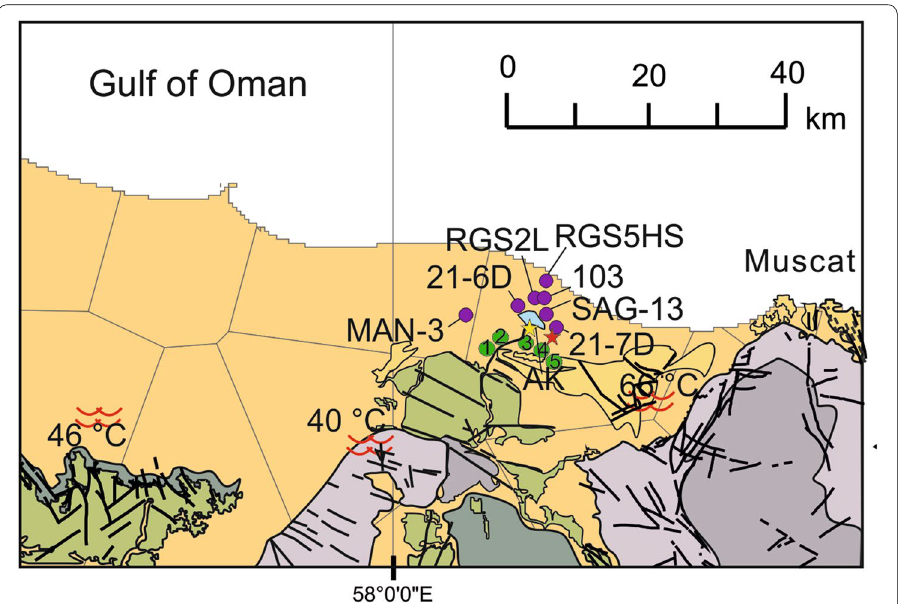
Fig. 2 Purple dots—location of the wells, where new continuous T-logs were recorded. Red waves—location of hot springs and temperature (data provided by the MRMWR). Green dots—location of outcrop sampling of the Barzaman Fm., Seeb Fm. and Oligocene carbonates (Ma’am reefs). AK—Al Khawd dam. Red star— site, where a thermally driven cooling system will be installed. Yellow star—well field with bottom-hole temperature (BHT) data (cf. Fig. 4). The geological units are described in Fig. 1. Black lines—major faults [modified from NF40-03, Seeb sheet, 1992, Sultanate of Oman, Ministry of Petroleum and Minerals; Kusky et al. (2005), Fournier et al.